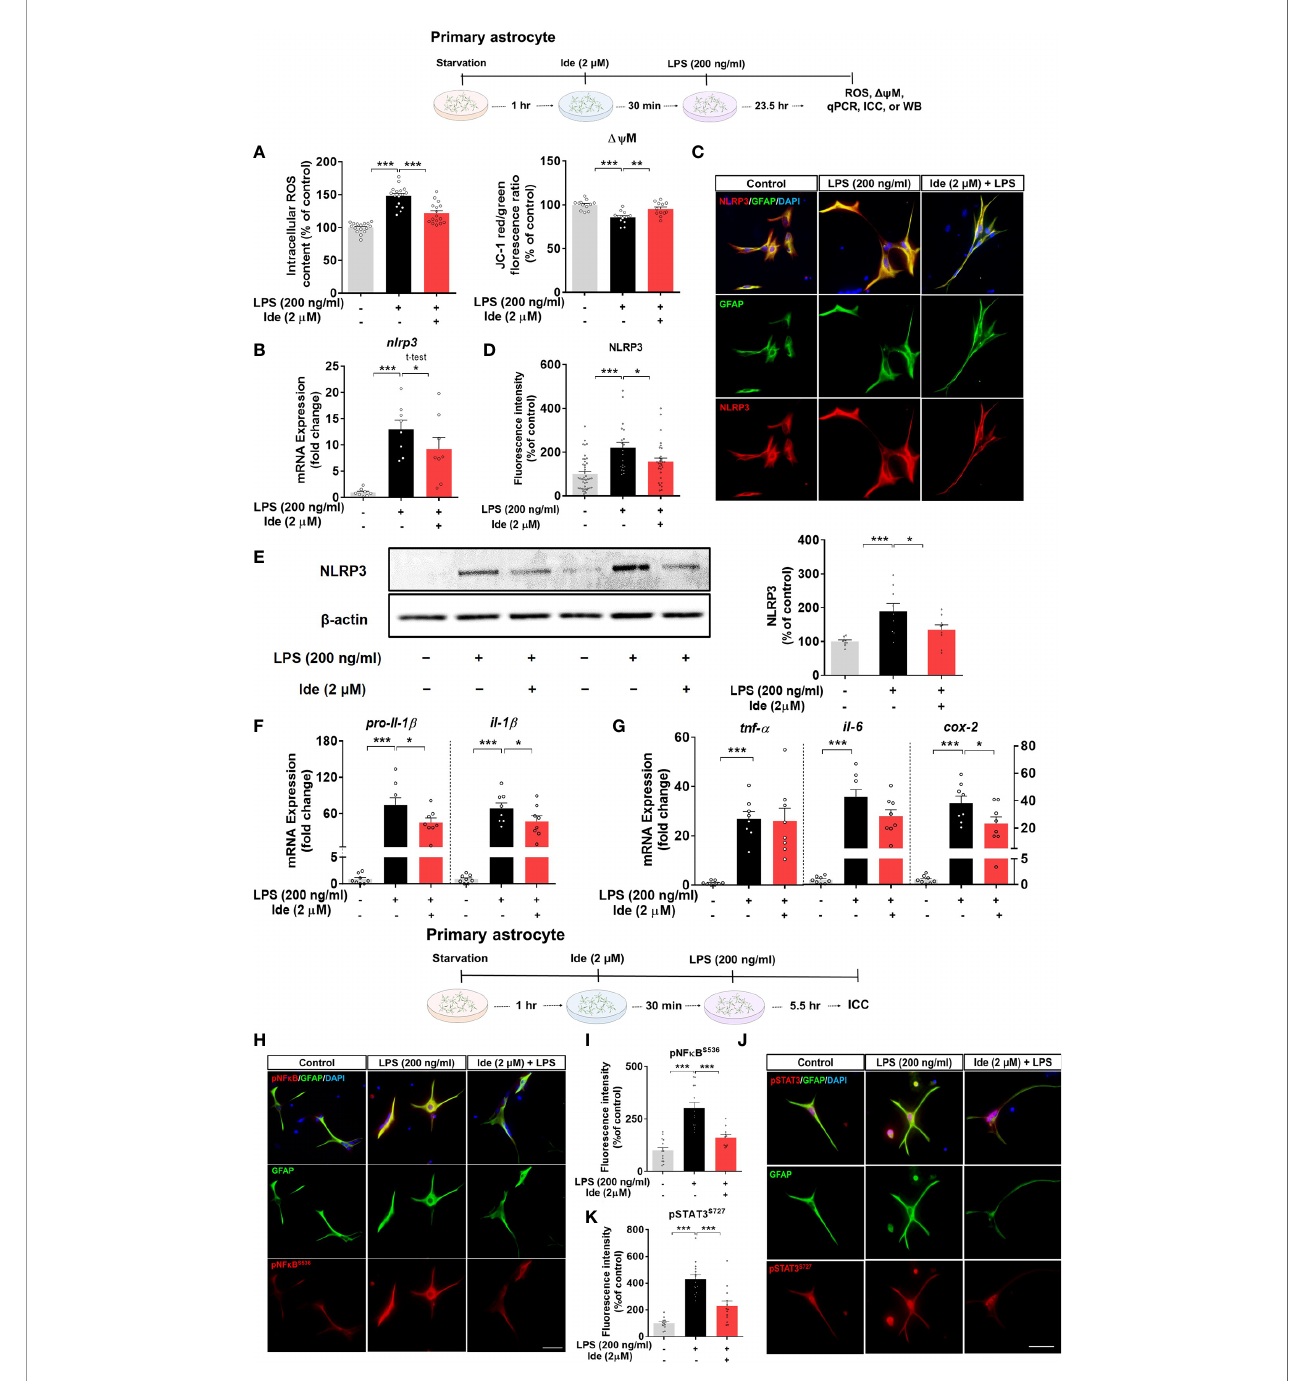
FIGURE 8 | Idebenone suppresses ROS/NLRP3/IL-1 b axis activation in LPS-stimulated primary astrocytes. Cells pretreated with idebenone (2 m M) or vehicle (1% DMSO) for 30 min were treated with LPS (200 ng/ml) or PBS for 23.5 h. ROS and mitochondrial membrane potential were analyzed, and real-time PCR and immunocytochemistry were performed. (A) Relative intracellular ROS levels and mitochondrial membrane potential (ROS, n = 16/group; mitochondrial membrane potential, n = 12/group). (B) Relative nlrp3 mRNA levels (n = 8/group). (C, D) Representative immunocytochemistry image and quanti fi cation of NLRP3 expression (Veh, n = 44; LPS, n = 35; and Ide + LPS, n = 41). (E) Representative immunoblots and quanti fi cation of NLRP3 protein levels (n = 9/group). (F) Relative mRNA levels of pro-il-1 b and il-1 b (n = 8/group). (G) Relative mRNA levels of tnf- a , il-6 , and cox-2 (n = 8/group). (H – K) Immunocytochemistry of p-NF-kB S536 and p- STAT3 S727 levels in primary astrocytes (Veh, n = 14; LPS, n = 13; and Ide + LPS, n = 14 for p-NF-kB S536 and Veh, n = 14; LPS, n = 13; and Ide + LPS, n = 13 for p-STAT3 S727 ). *p < 0.05, **p < 0.01, and ***p < 0.001. Scale bar = 50 m